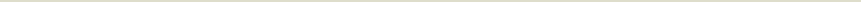
Table 4 | Key terms included in search strings Concepts Key terms in search strings